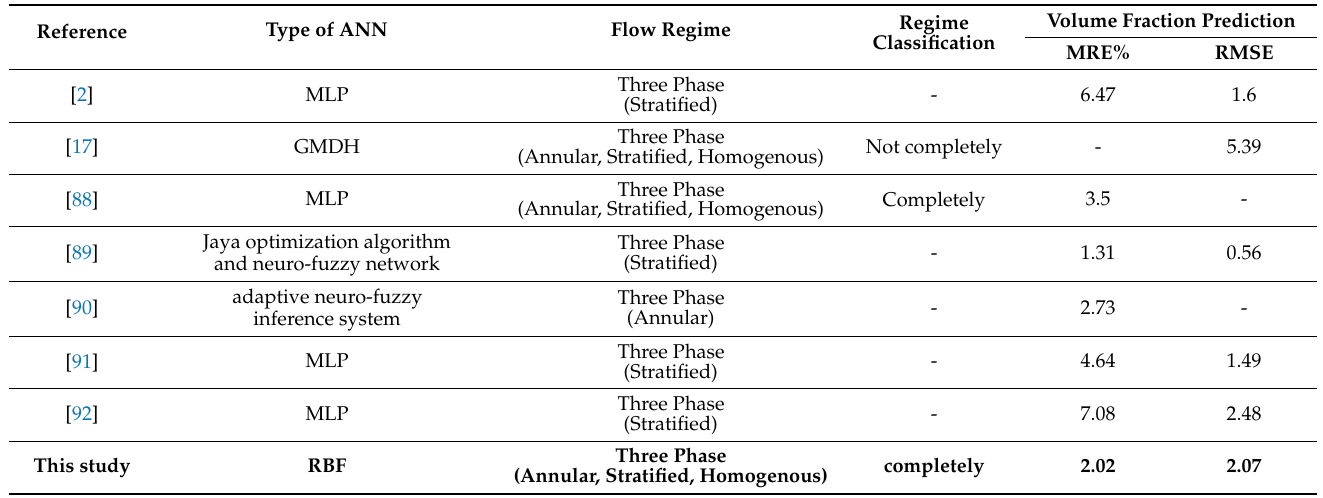
Table 4. Comparison of the proposed method with some previous